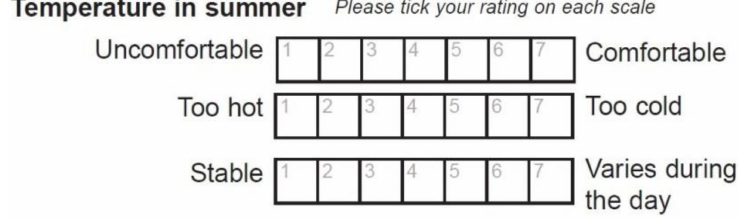
Figure 5. BUS question